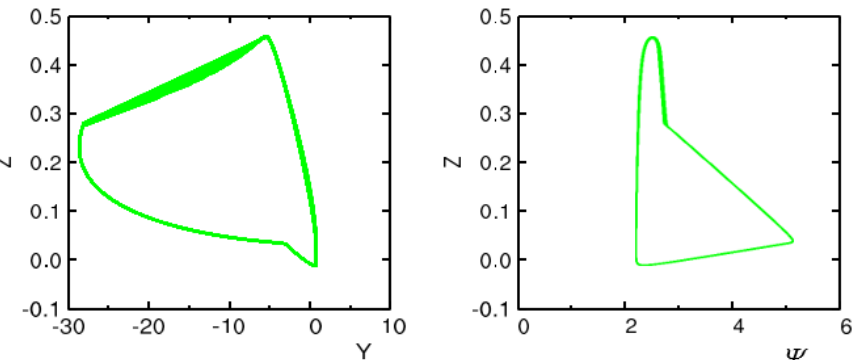
Figure A2. Numerical solution of Equation (A10) with L = 10,000 km. The projections on the ( left ) Y – Z and ( right ) Ψ – Z plane in the phase space of the segment of the trajectory extending from τ = 8,000 to 10,000.